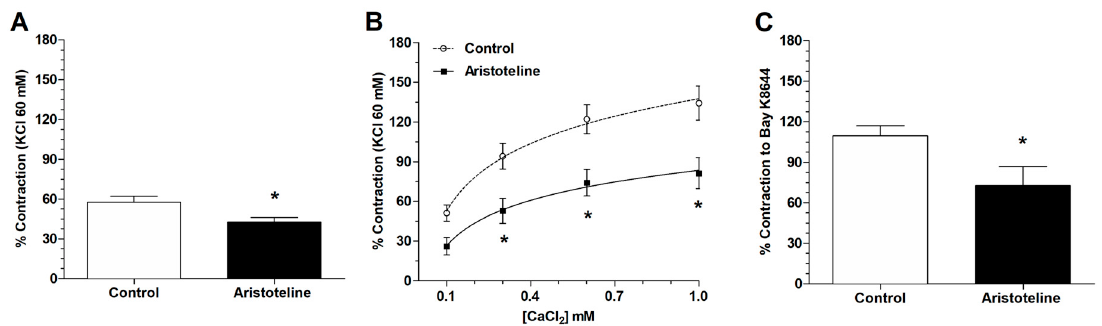
Figure 5. Effect of ARI on calcium release from the phenylephrine-sensitive intracellular calcium stores. The aortic rings were pre-incubated in a free calcium buffer for 10 min before PE was added ( A ), and then, the CaCl 2 (0.1, 0.3, 0.6, and 1.0 mM) was added to the bath ( B ). Vasoconstriction occurred just when the agonist of Ca V 1.2 channels (10 nM Bay K8644) was added with 15 mM KCl to the bath ( C ). The aorta was pre-incubated in absence (control) or presence of ARI (10 μ M) for 20 min. Values are mean ± standard error of the mean of 6 experiments. Statistically significant difference * p < 0.05 vs. Control.